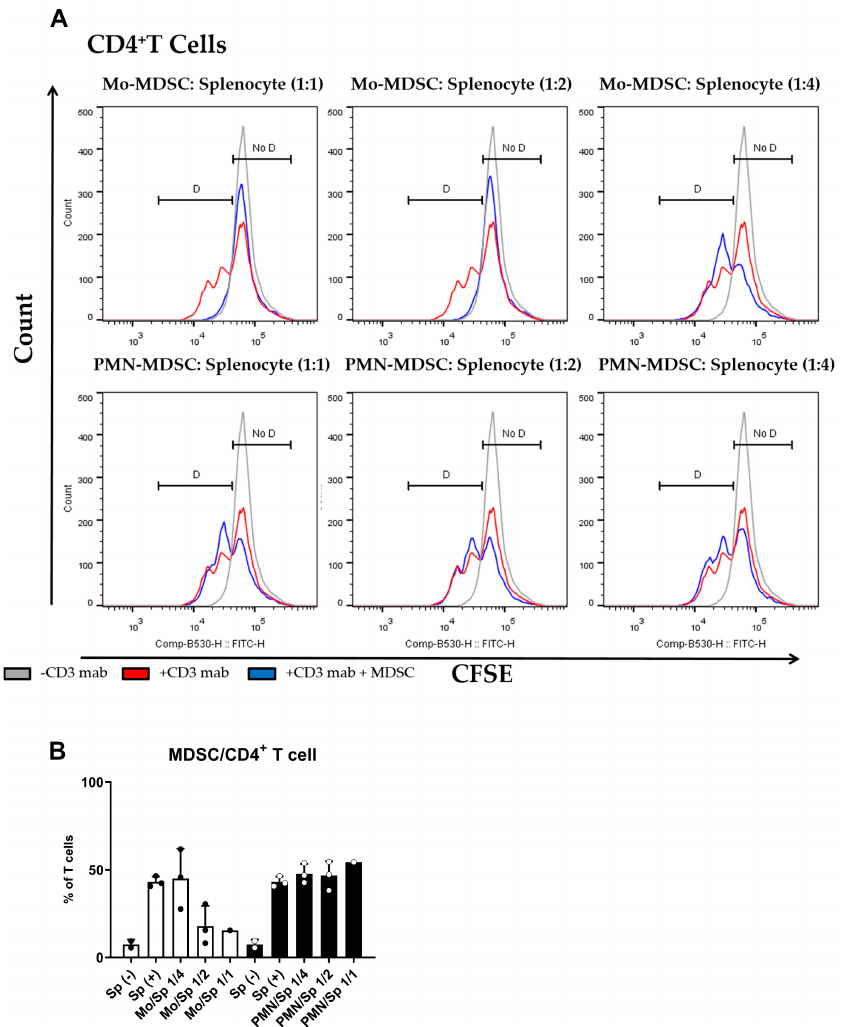
PMN-MDSCs (lower row) isolated freshly from LLC tumors at the indicated cell ratios. As controls, stimulated splenocytes (red) and unstimulated splenocytes (grey) were cultured separately. Genera- tions of proliferating CD8 + T cells were identified using the histogram of unstimulated splenocytes as reference (D: proliferating cells, No D: non-proliferating cells). Histograms show one representative experiment out of three independent ones. ( B ) Quantification of the proliferation of CD8 + T cells in the presence of MDSCs. The percentage of proliferating CD8 + T cells in each condition was determined as D/(D + No D) × 100 where “D” and “no D” indicate the number of cells in the corresponding regions in panel A. PMN-MDSCs (empty circles and filled bars) and Mo-MDSCs (filled circles and empty bars) were used at indicated MDSC/splenocyte ratios and cultured following activation by anti-mouse CD3. Sp (+): anti-mouse CD3 stimulated splenocyte in the absence of MDSCs; Sp ( − ): unstimulated splenocytes in the absence of MDSCs. Bars and error bars indicate mean ± SD.